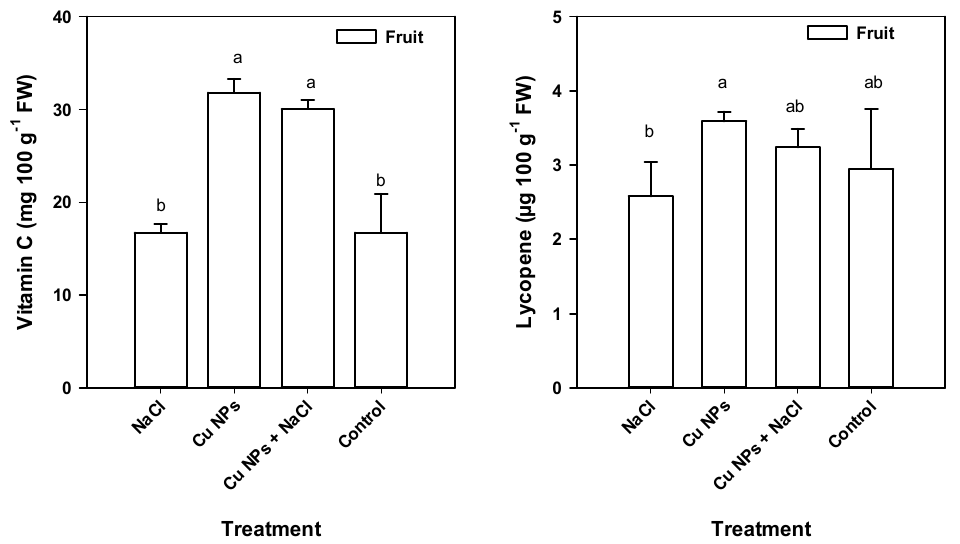
Figure 4. Vitamin C and Lycopene in the fruits of tomato plants exposed saline stress and treated with foliar application of Cu NPs. All data are the mean of six replicates ± standard error. Different letters indicate significant differences between treatments according to Fisher’s Least Significant Difference ( p ≤ 0.05); ns—not significant.